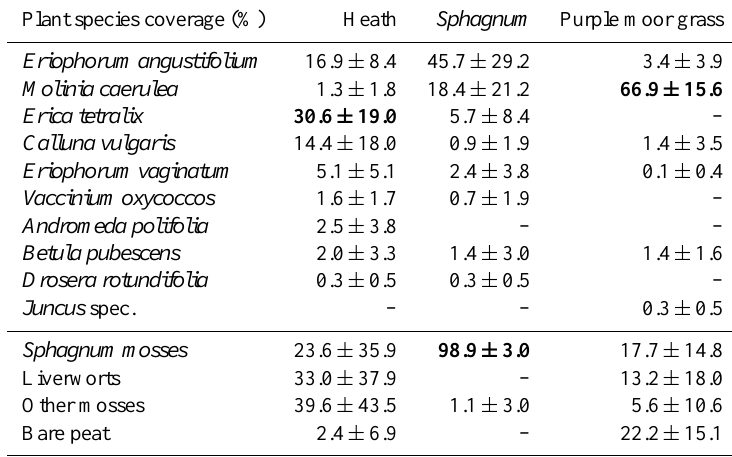
Table 2. Average coverage of vascular plant species according to Londo (1976) at the three rewetted bog sites in 2011. Coverage of the moss layer and bare peat areas were estimated using pointintercept sampling (Jonasson, 1988). Values refer to means of 7–8 replicates ± SD. Numbers in bold print indicate eponymous species for site denotation. Sphagnum species were mainly S. cuspidatum and S. fimbriatum . A dash indicates that the species was not found.